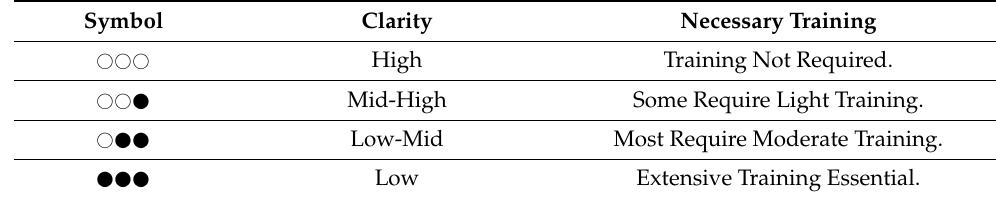
Table A1. Literature Summary Tables: Interpretive clarity scale.